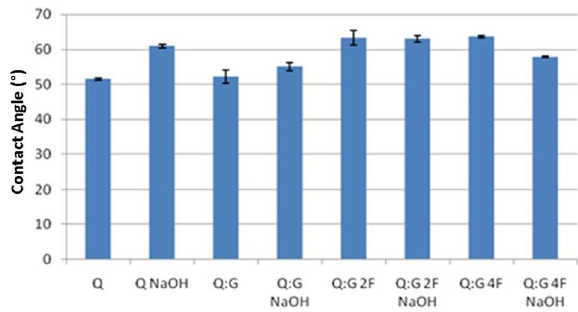
Fig. 5 Surface tension by contact angle measurements of chitosan membranes with and without gelatin and